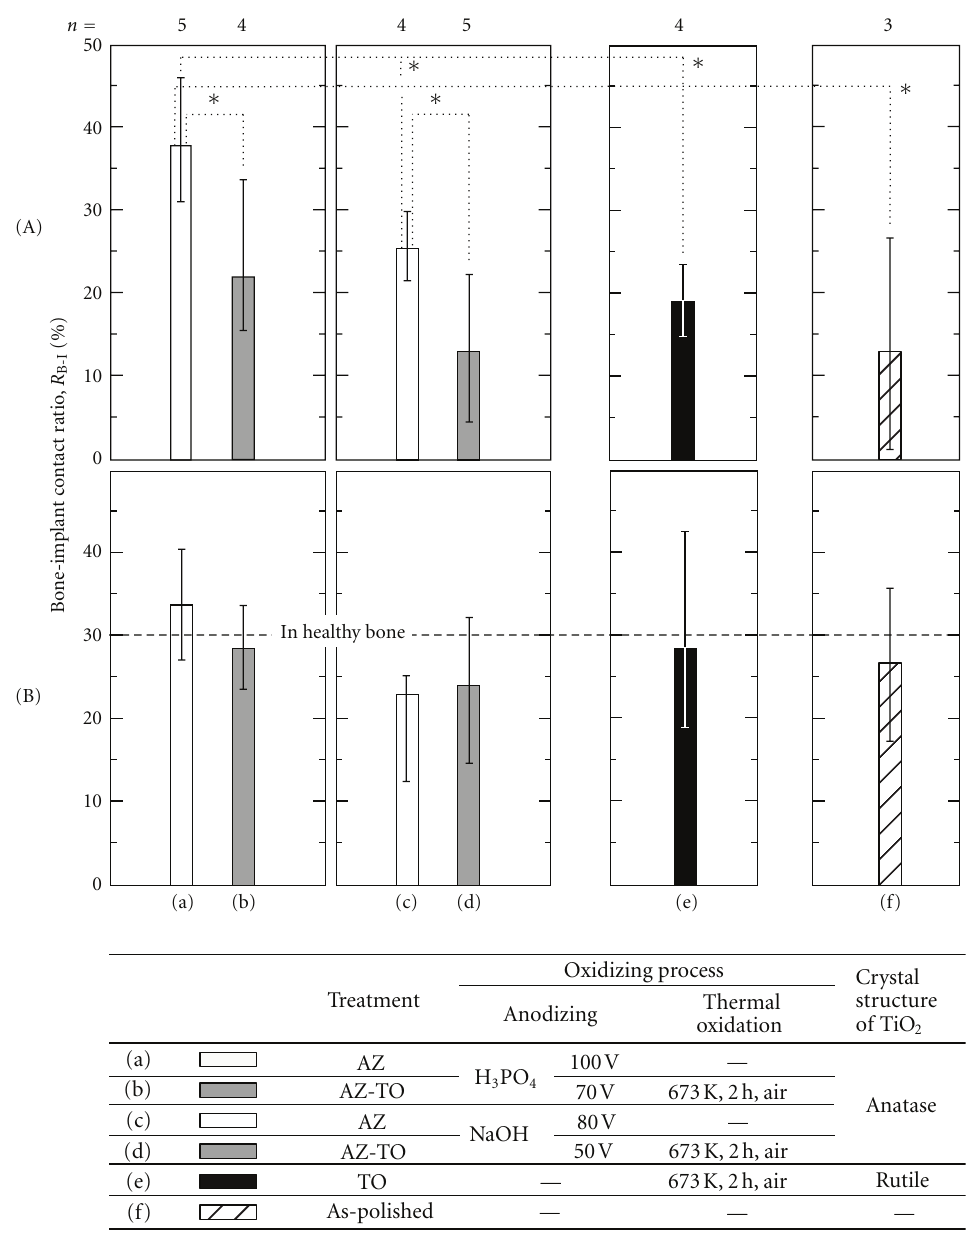
Figure 4: Bone-implant contact ratio, R B-I , of Ti samples in both (A) the cortical bone part and (B) the cancellous bone part. ∗ P < 0 . 05.